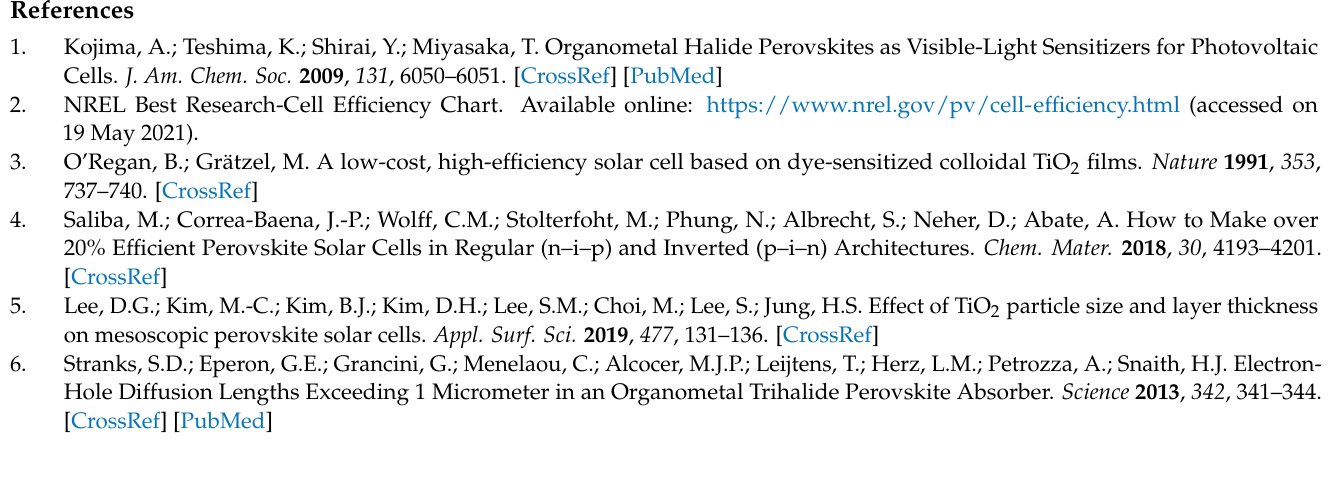
Table S2: Electrical parameters of the studied FTO/b-TiO2/MAPbI 3 /Spiro-OMeTAD/Au solar cells: short-circuit current density (J SC ), open-circuit voltage (V OC ), fill factor (FF) and power conversion efficiency (PCE), Figure S3: SEM images showing the morphology of the MAPbI 3 perovskite layer deposited on glass/FTO/c-TiO 2